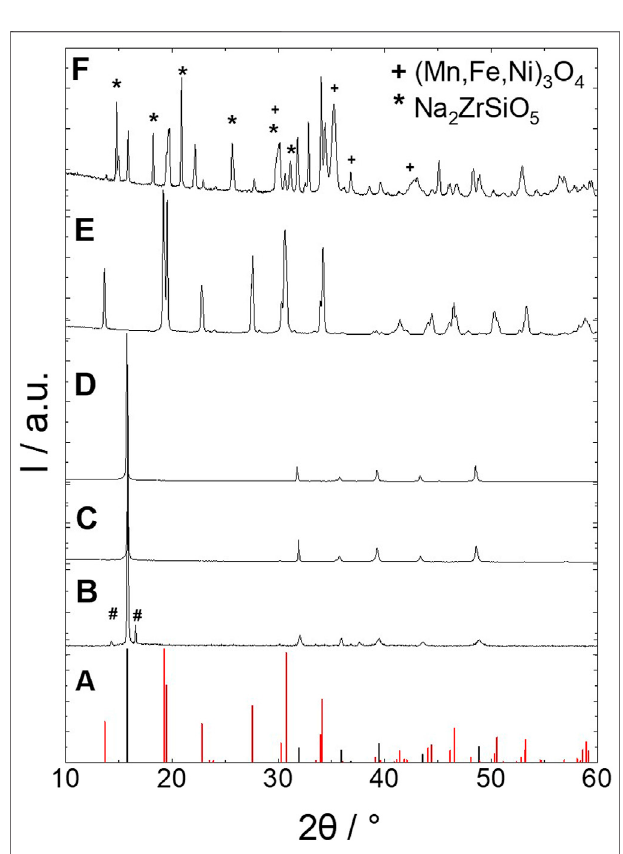
FIGURE 6 | XRD patterns of NNFM heat treated at (B) 800 ° C, (C) 1,200 ° C, (D) 1,260 ° C, (E) NZSiP heat treated at 1,260 ° C and (F) NNFM/ NZSiP co-sintered at 1,200 ° C. Stars and pluses highlight secondary phases. For comparison the (A) XRD patterns of NNFM (black) and NZSiP (red) are also shown from literature (Ma et al., 2019; Choi et al.,